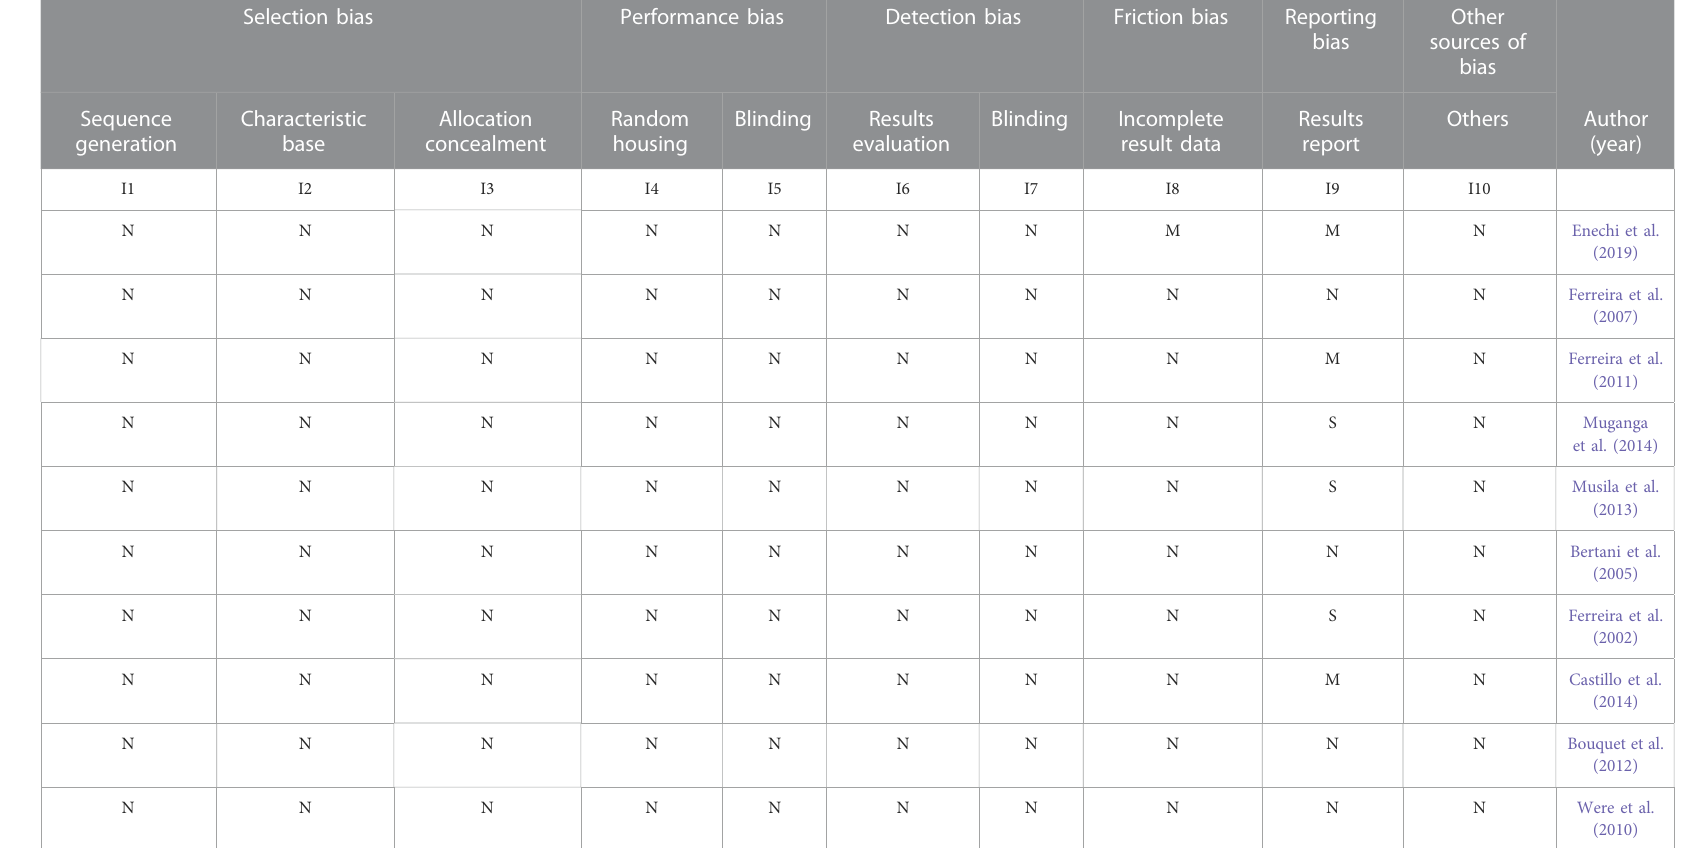
TABLE 2 Results of in vivo